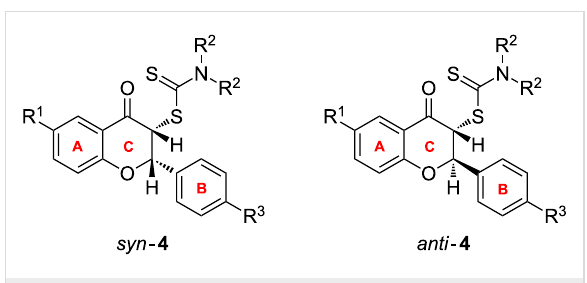
Figure 2: The syn and anti -isomers of flavanones 4 .